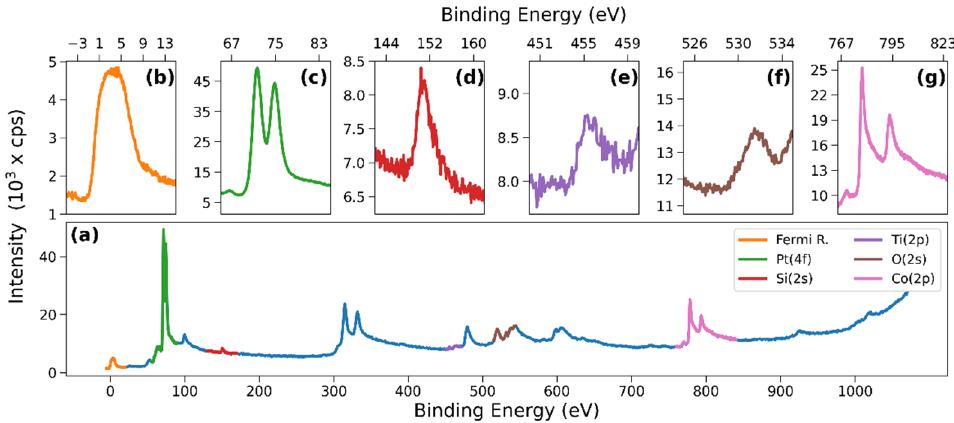
Figure A2. X-ray photoemission spectra of tpc sample recorded from the top of first Co layer. The survey spectrum is used to detect any contamination on the sample and check the general structure of the sample ( a ). High resolution windows of each layers and substrate is used to check the consistency of the photoemission cross section and the change in the chemical state of any layer (or substrate) ( b – g ).